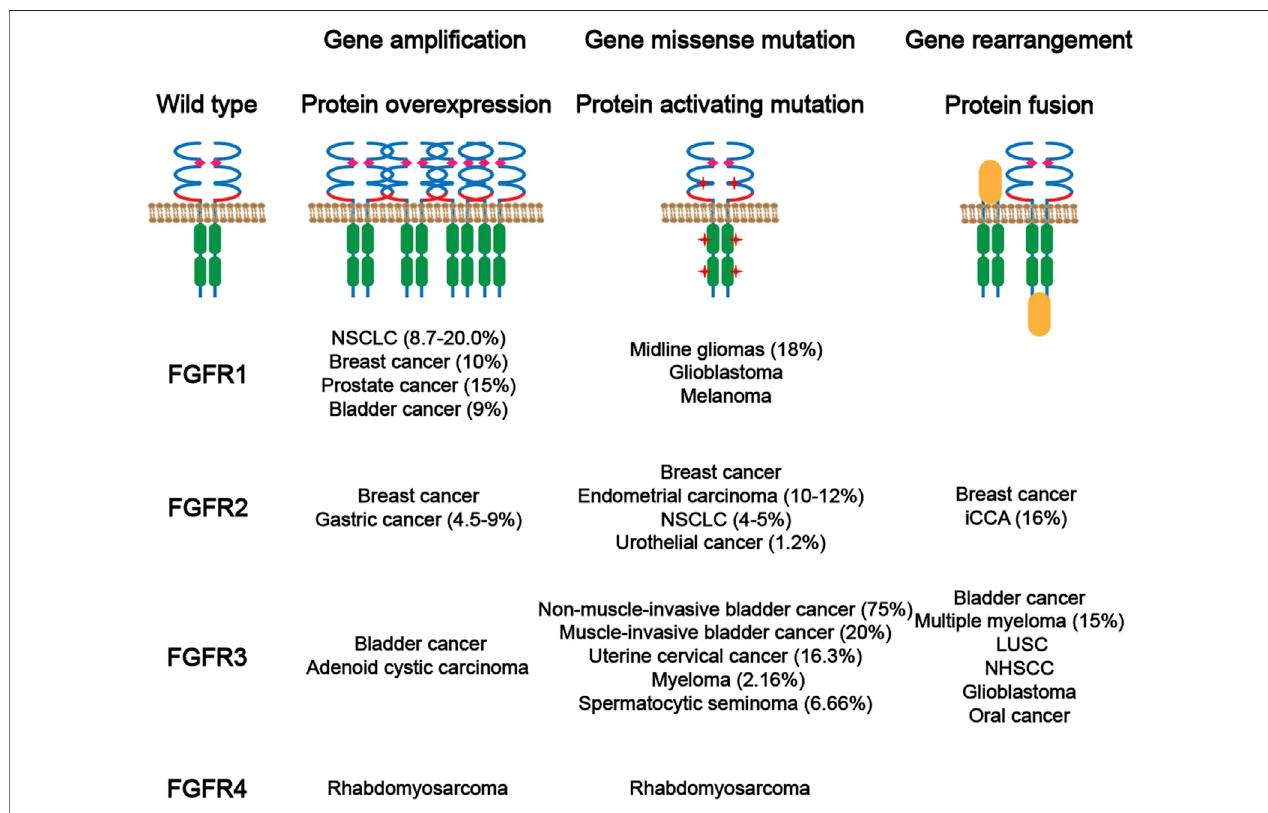
FIGURE 4 | Main abnormalities in FGFRs and their frequency in related